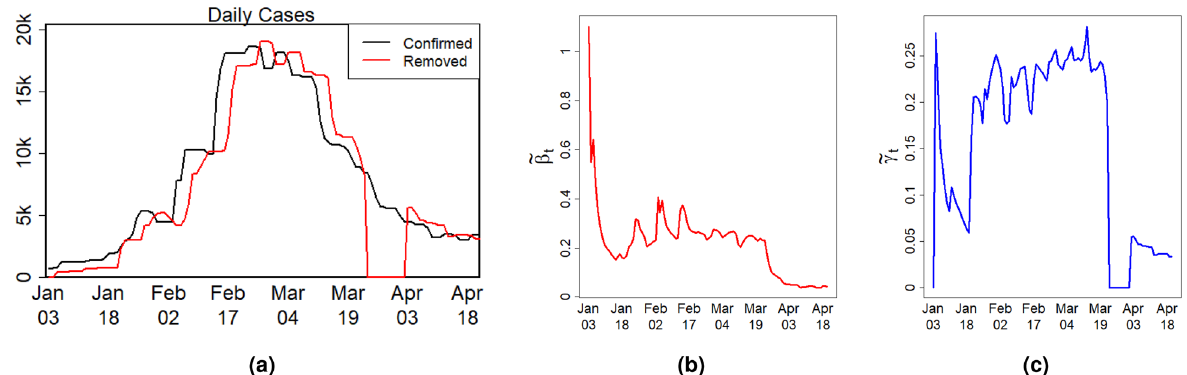
Figure 5. ( a ) The numbers of daily confirmed and removed COVID-19 cases, ( b ) the naive estimator of the time-varying transmission rate, and ( c ) the naive estimator of the time-varying removal rate during the Omicron wave in